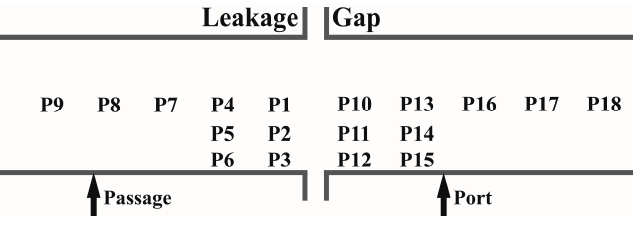
Figure 13. Distributions of the flow parameter monitors.